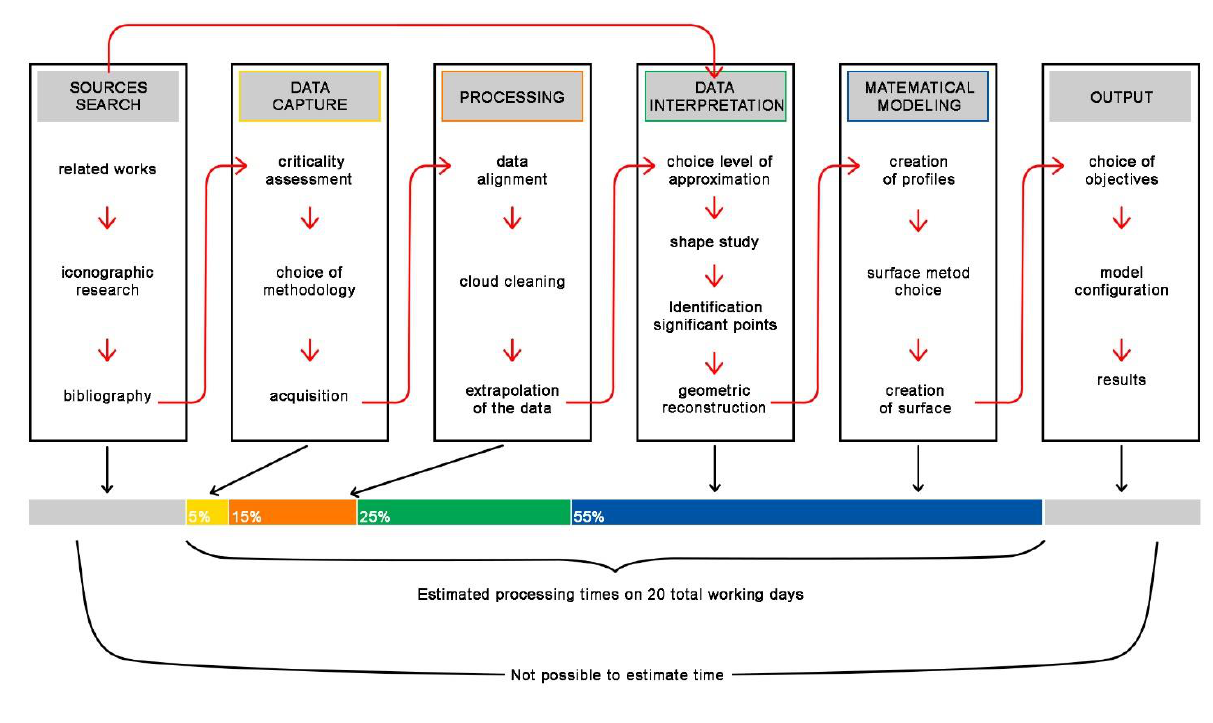
Figure 10. Pipeline of the Reverse Modeling process applied to Cultural Heritage composition rules codified in the architectural treatises, in order to obtain a final reconstruction model as the best possible solution between the preservation of acquired 3D data and his interpretation. To obtain this result, a reconstruction tolerance